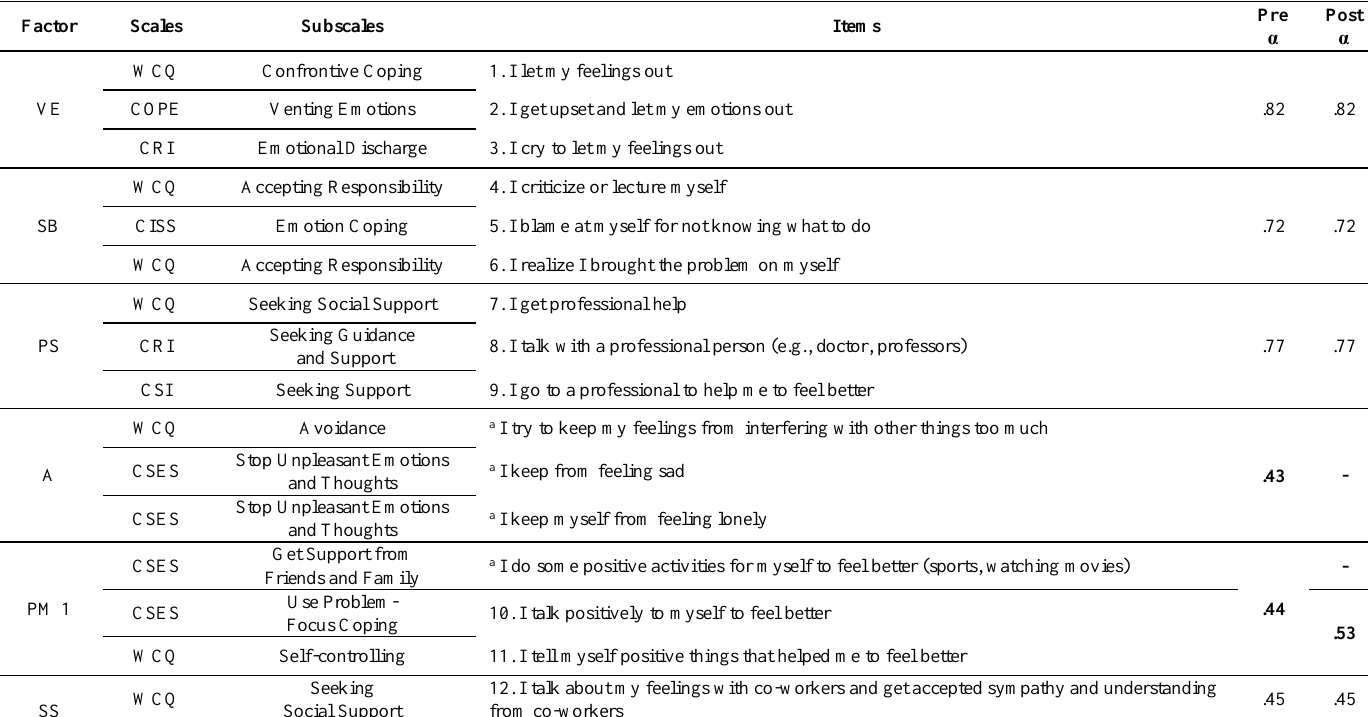
Emotional coping items and reliability changes between pre- and